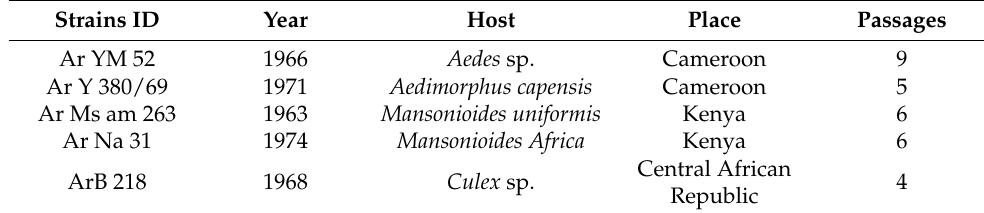
Table 1. Strains used in this